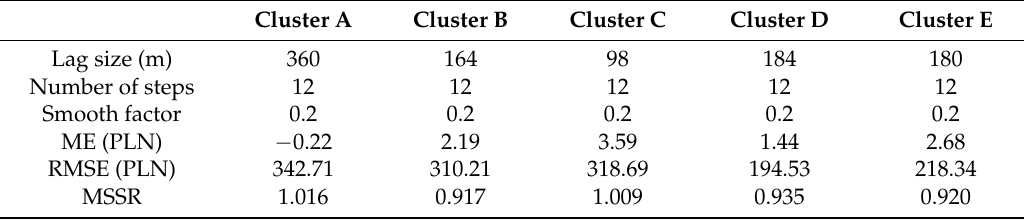
Table 5. Semivariogram parameters and errors of pure spatial model